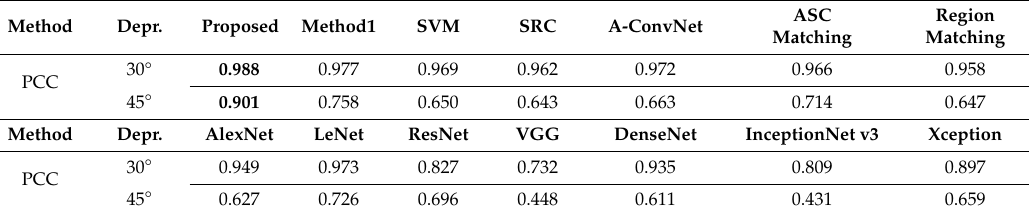
Table 12. Comparisons with other methods to the